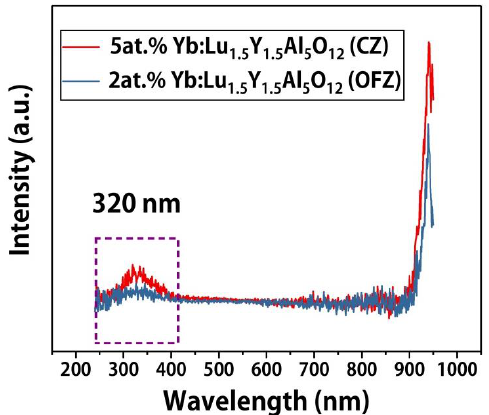
Figure 6. X-ray excited emission spectrum at room temperature.